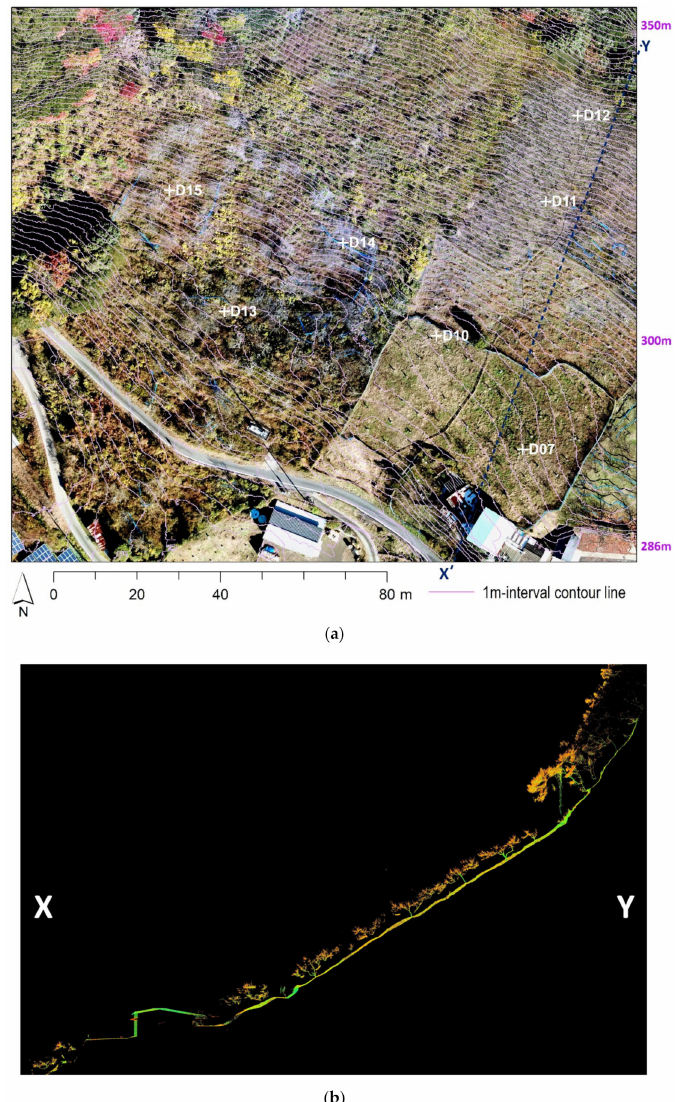
Figure 5. Microtopography of the western part of the traditional Ume orchard site based on an ortho drone image ( a ) and a transect sliced from the point cloud ( b